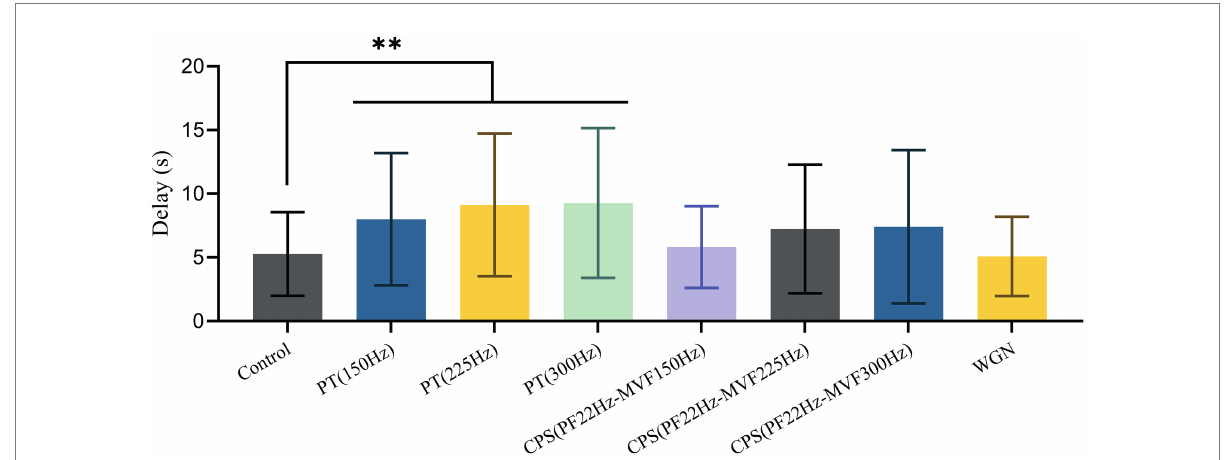
FIGURE 5 Mean ± SD of male reply delay from the female courtship signal with or without disruptive signals. Differences from the Kruskal–Wallis test followed by Dunn’s pairwise comparisons are denoted as follows: ** p <